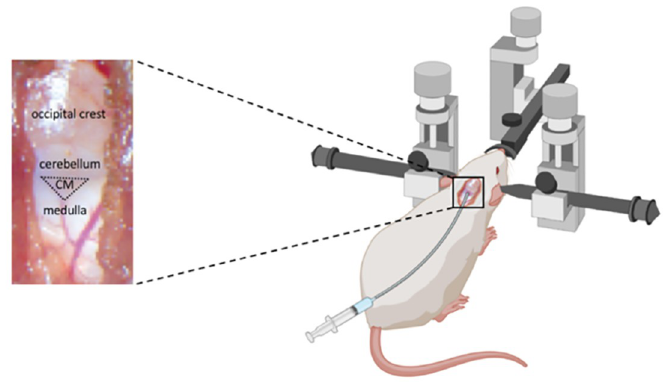
Fig 2. Cisterna magna cannulation. Rat was placed in the prone position in a stereotaxic frame, using tooth and ear bars for stabilisation with the head fixed to 45˚ (snout). A 3 cm skin incision was made in the midline of the dorsal neck to expose the occipital crest and dural membrane covering the cisterna magna. A custom-made CM cannula (22-gauge, 2 mm Tip PEEK, SAI Infusion Technologies, RCMC-03) was advanced 2 mm into the subarachnoid space (i.e. CM space). CM: cisterna